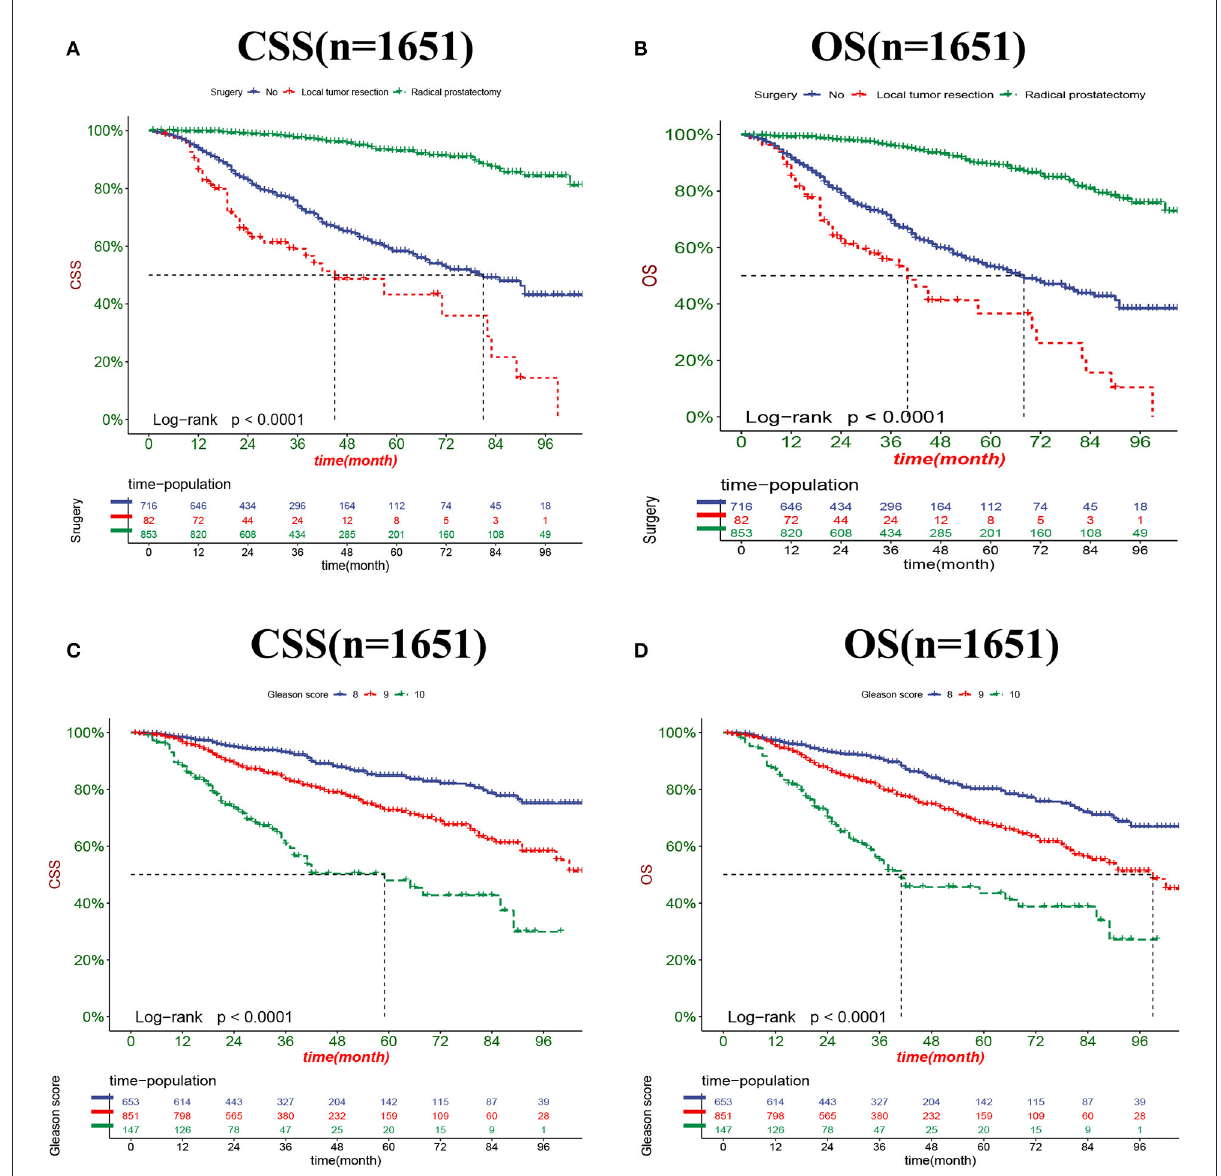
FIGURE7 Kaplan-Meier curves for predicting CSS and OS in patients with different surgery (A,B) and GS (C,D)